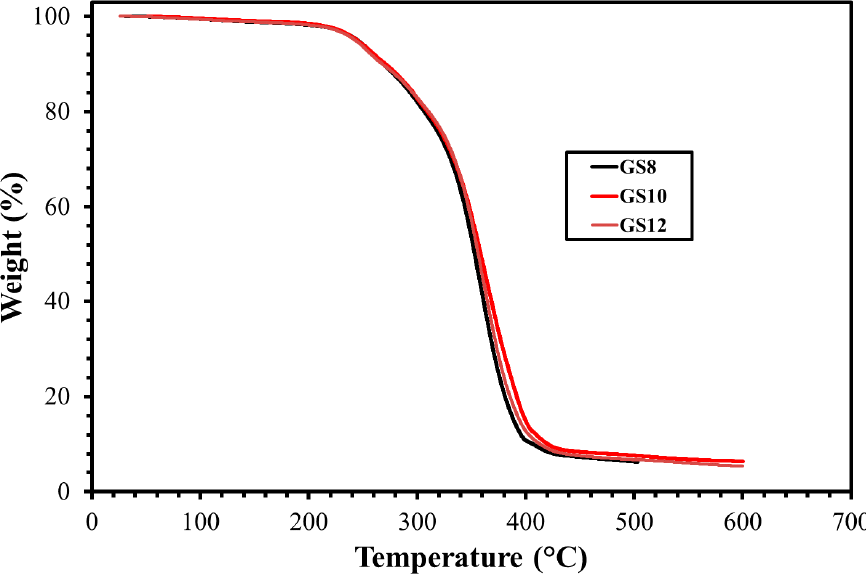
Figure 6. Thermal gravimetric analysis of gemini surfactants with different spacer length.